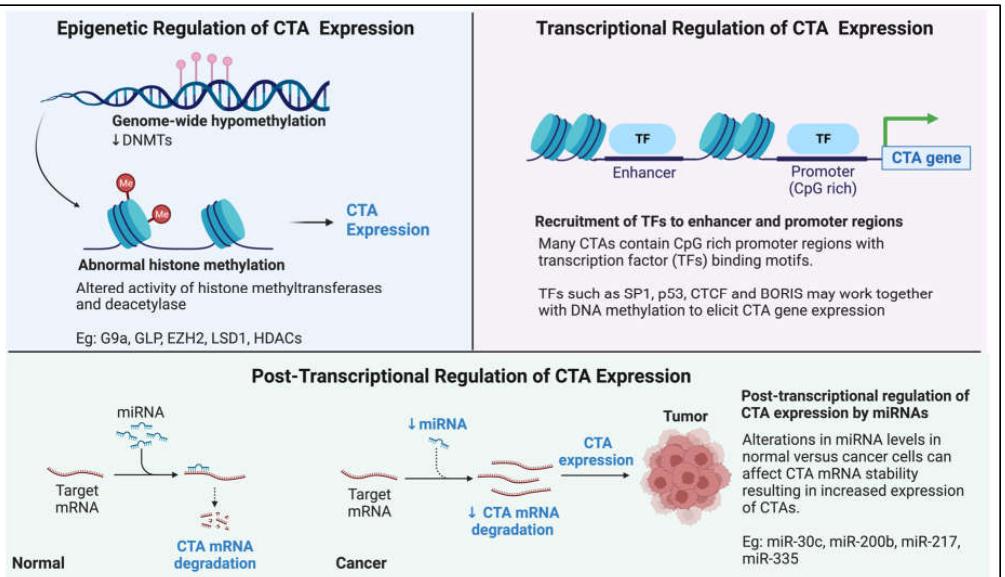
Figure 3. Pictorial summary of our current knowledge on how cancer-testis antigen ( CTA ) expres- sion is regulated in the context of cancer. is regulated in the context of